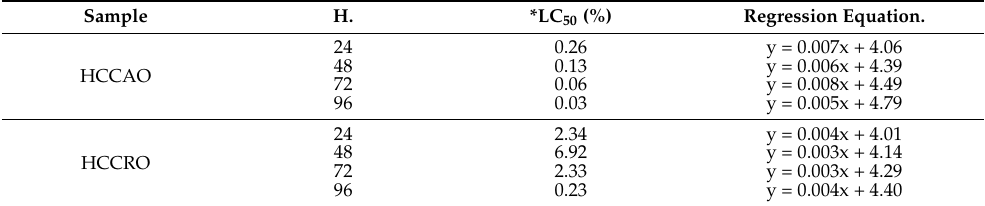
Table 3. LC 50 values of HCCAO and HCCRO for nematicidal activity against second-stage juveniles (J 2 ) of M. incognita . Sample